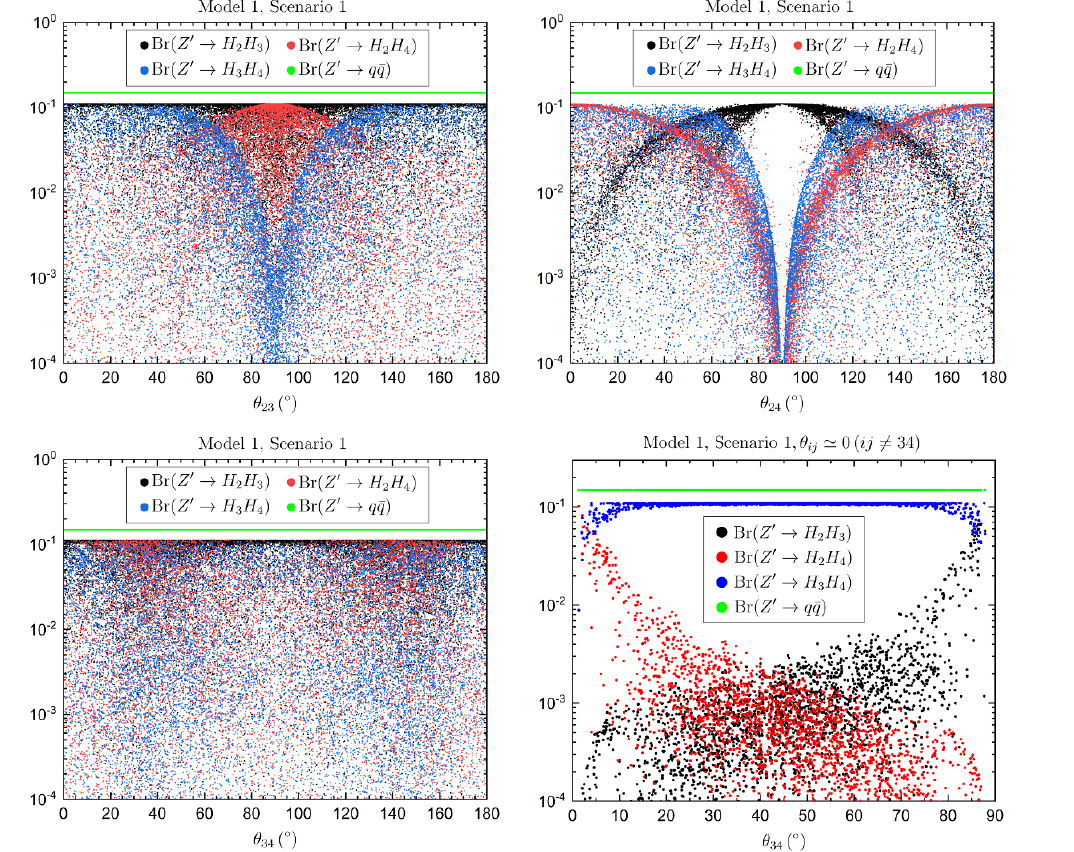
Figure 1 . Z 0 branching ratio to di(cid:11)erent scalar pairs in scenario 1 of model 1. We scan over the input parameters (cid:18) ij and (cid:21) 2 keeping only those points which lead to a viable minimum of the potential. The mixing angles (cid:18) 23 , (cid:18) 24 and (cid:18) 34 are unrestricted, except in the bottom right panel where (cid:18) 23 and (cid:18) 24 are taken small (see the text). The U(1) 0 coupling is such that g Z 0 z = 0 :